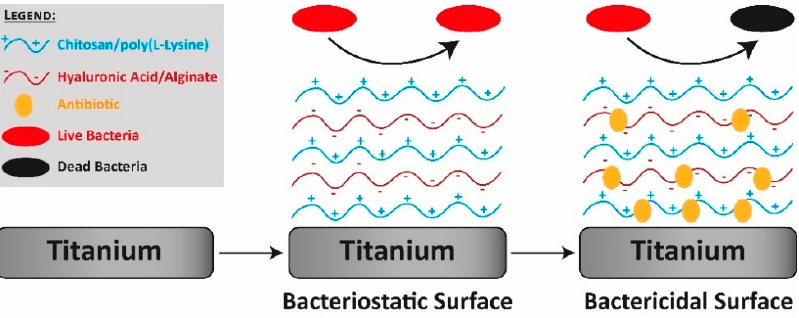
Figure 4. Layer by layer coating of polycationic and polyanionic polymers to make bacteriostatic surfaces. Reproduced and adapted from Chouirfa et al. 2019 [35], with permission from Elsevier.